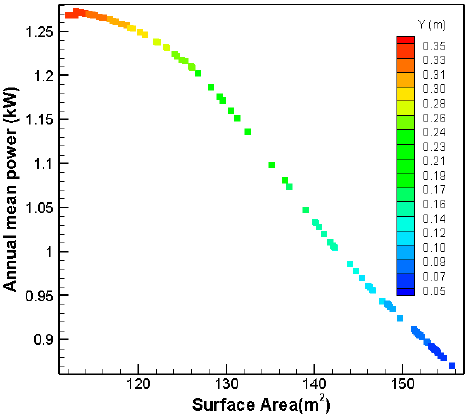
Figure 18. Optimization results of the bottom cut shape.